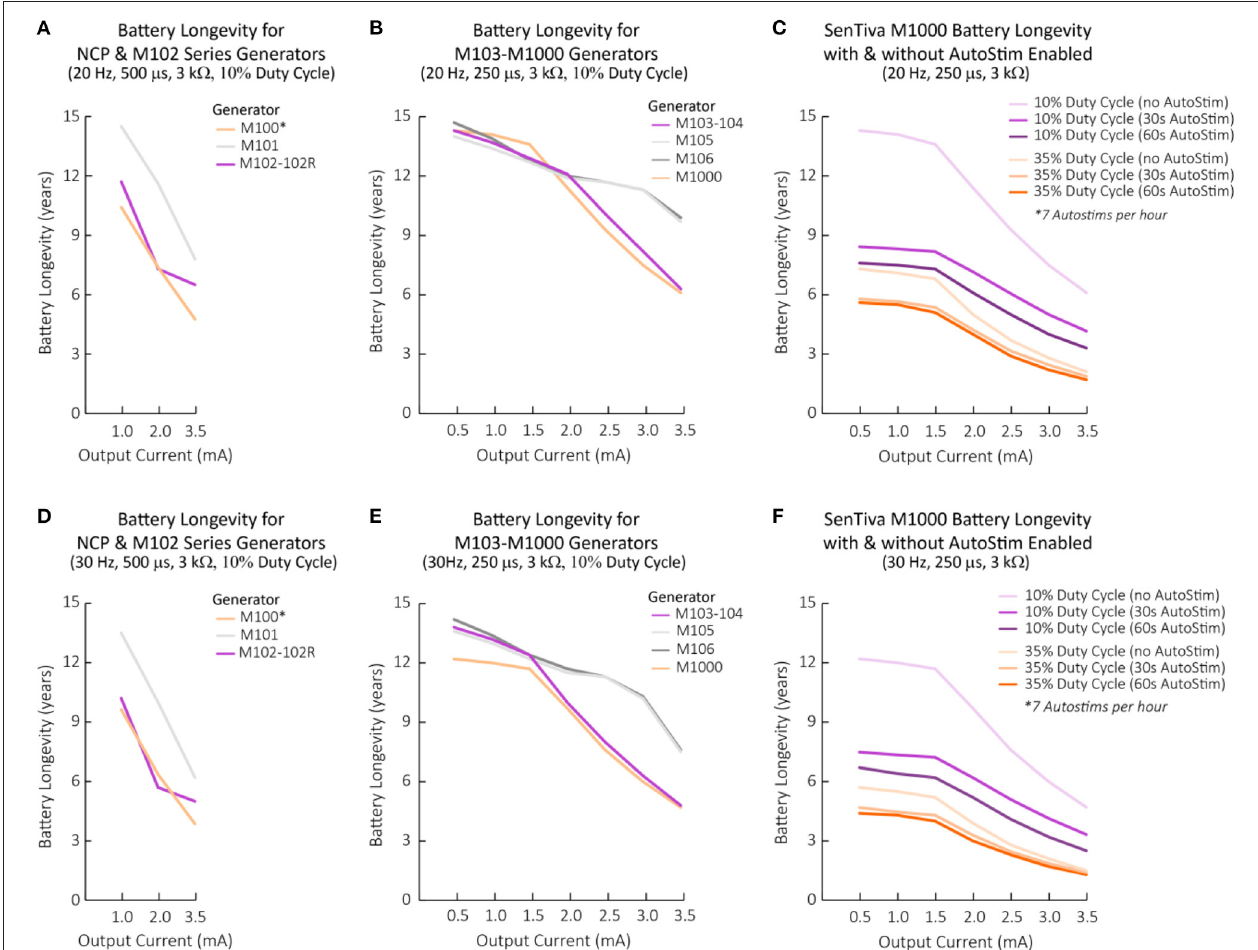
FIGURE 4 | Battery longevity projections for each VNS Therapy generator with respect to programmed stimulation settings. Battery longevity projections under various stimulation parameter settings calculated based on modeling from a generator’s beginning of life until EOS ( 3, 23). (A–C) Battery longevity projections for generators programmed at 20Hz with a typical lead impedance of 3 k Ω across varying output currents. Other stimulation parameters are displayed above the graph in brackets and in the legend, if applicable. (D–F) Battery longevity projections for generators programmed at 30Hz with a typical lead impedance of 3 k Ω across varying output currents. Other stimulation parameters are displayed above the graph in brackets and in the legend, if applicable. (A,D) 500 µ s was the lowest tested pulse width reported for NCP generators (23). 500 µ s was used for M102 series generators for comparison purposes. For the M100 generator, calculations for serial numbers > 10,000 were used. (C,F) The M1000 battery longevity with and without AutoStim enabled. Calculations based on 7 AutoStims per hour. Note that figure should not be used to exactly predict battery EOS but illustrates the effect of various parameters changes on battery life. AutoStim, autostimulation; EOS, end of service; M,